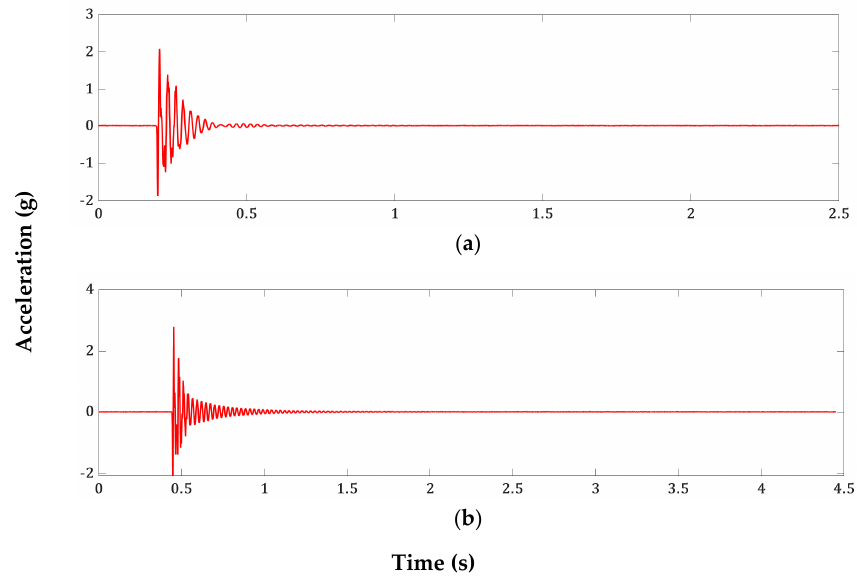
Figure 6. Typical acceleration–time history plots for ( a ) HLH4; ( b ) MLM4. After FFT programming from MATLAB, the results of the fundamental frequency were determined based on the strong peak of the frequency response spectrum. Figure 7 is a typical result of the frequency response spectrum.